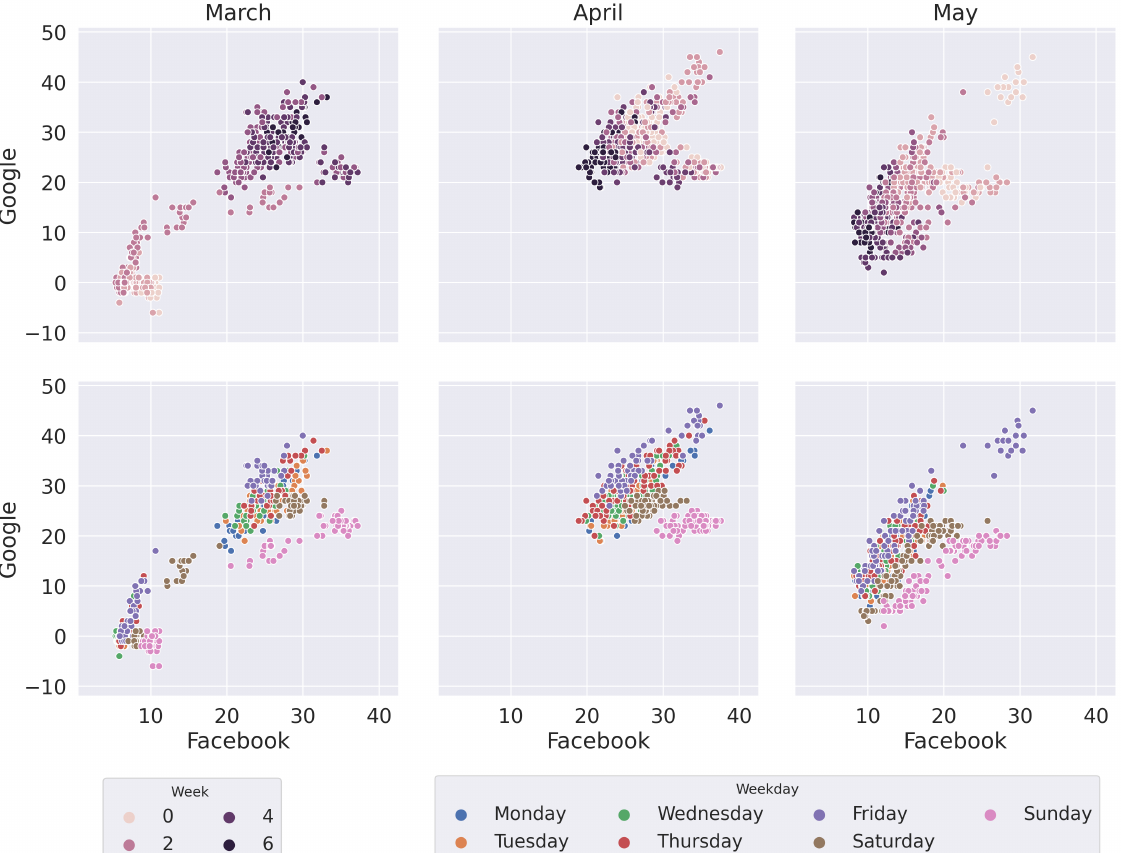
Figure 6. Evolution of mobility for Facebook (horizontal axis) and Google (vertical axis) data. Each dot represents a single day in a single region. First column holds data for March, second for April and third for May. First row shows the data with a color gradient indicating the week of the month. Second row shows the same data colored based on day of the